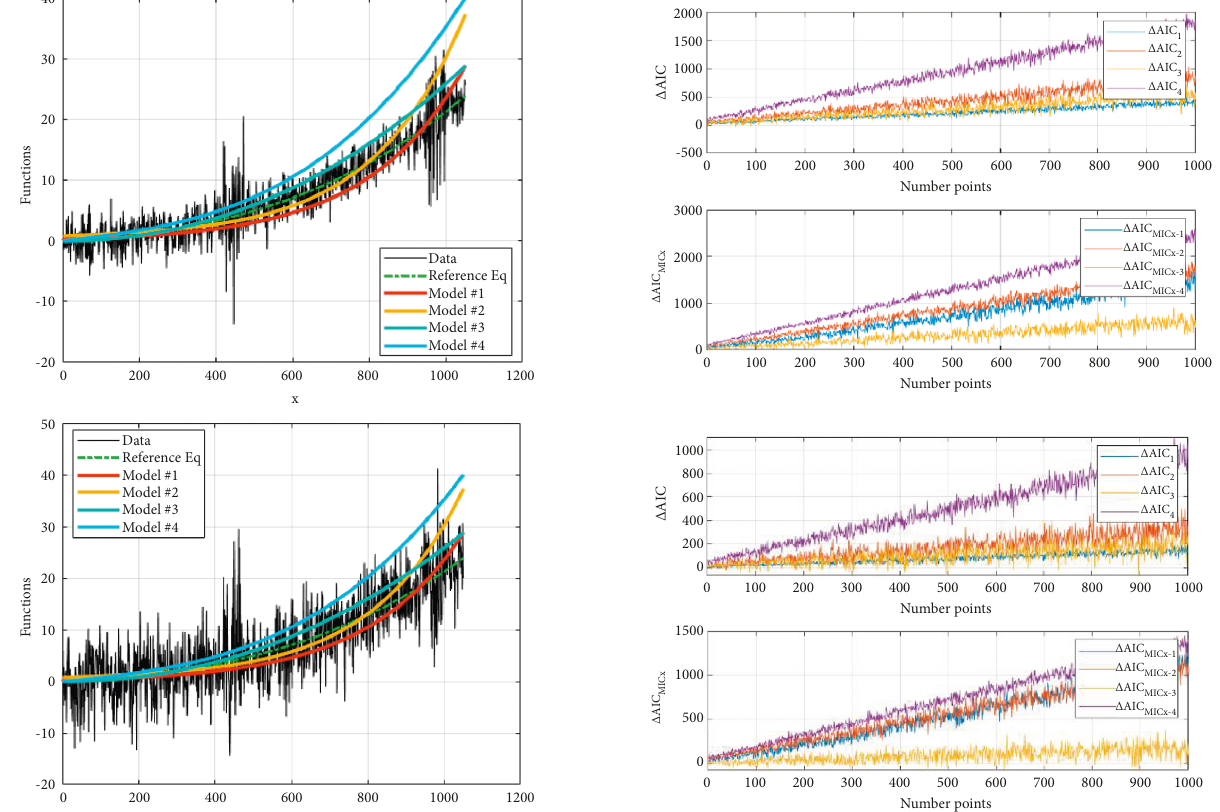
Figure 4: Model selection performances for two levels of additive noise: 30% top and 60% bottom. For each level of noise, the top plots show in black the synthetic data generated with the reference equation of Table 4. The coloured curves are the various candidate models and in dashed point green is the reference one. The bottom plots are the comparison of AIC and AIC MICx results in terms of the difference with respect to the exact reference model.